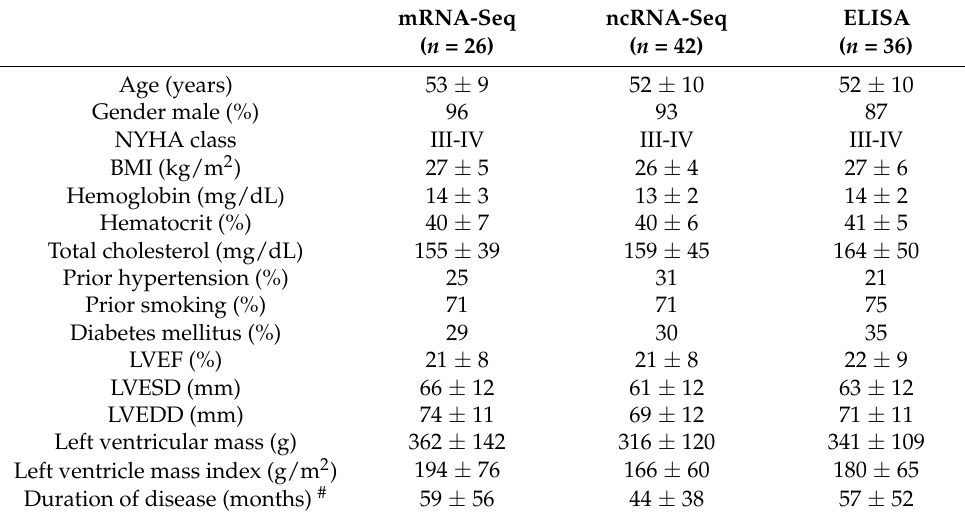
Table 1. Clinical characteristics of heart failure patients.